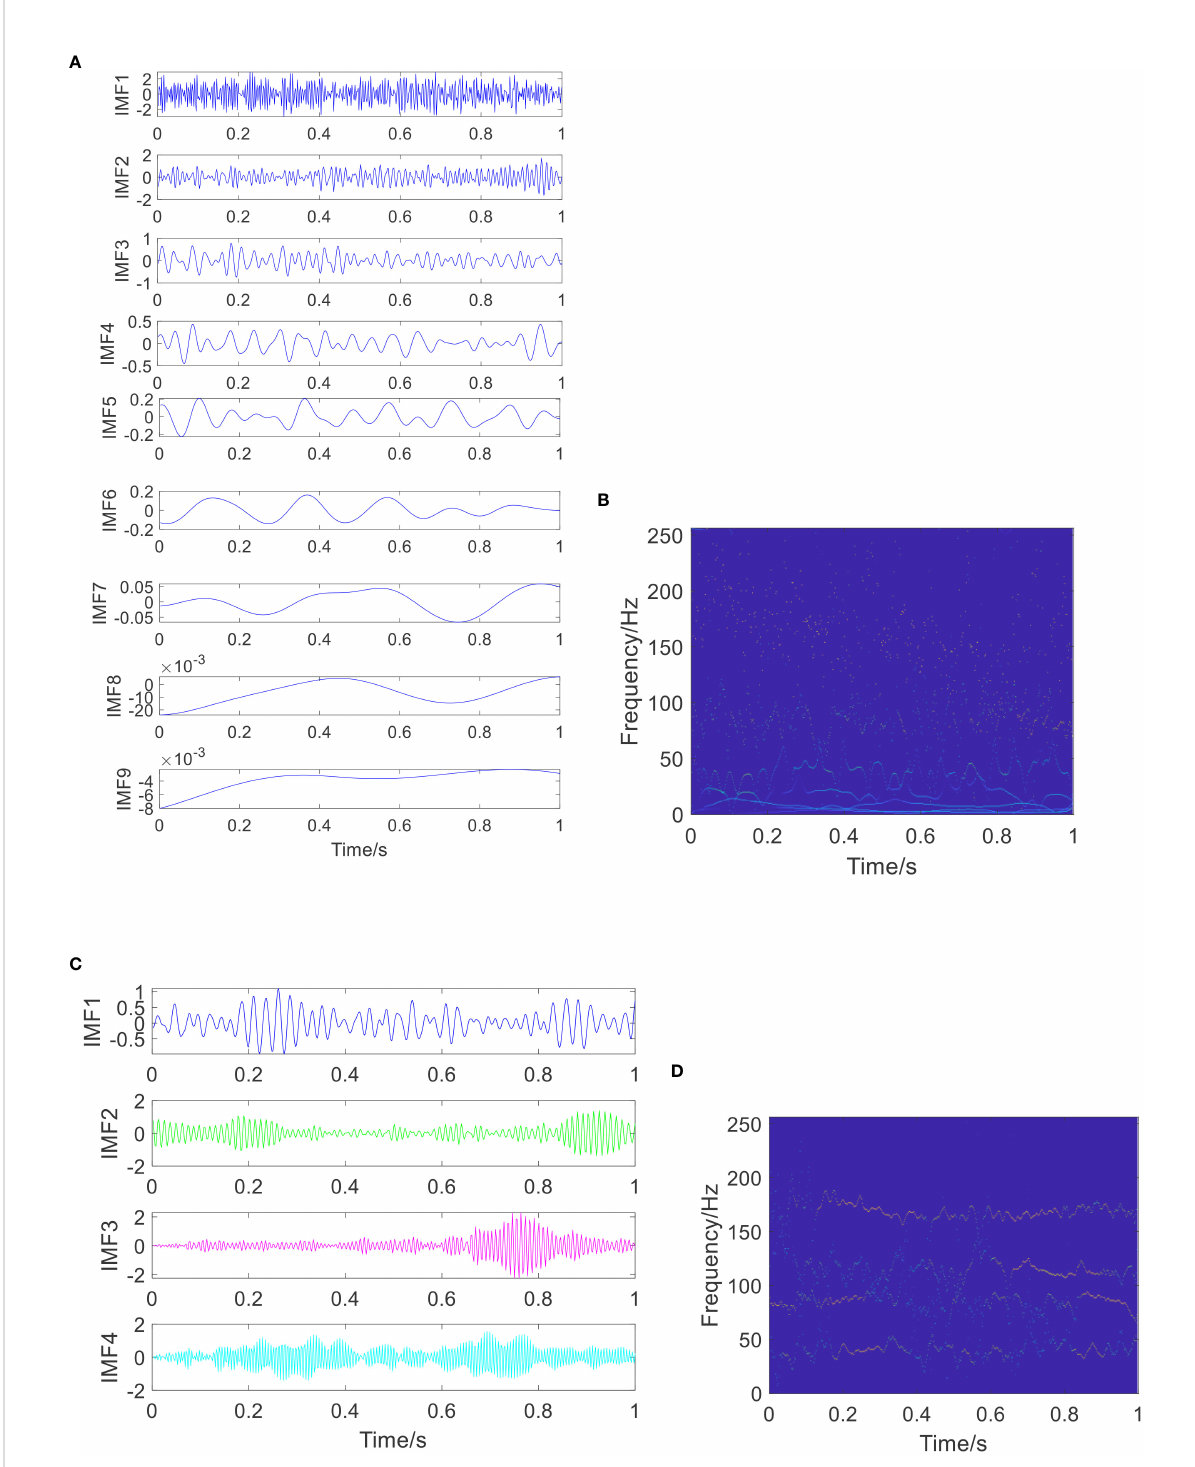
FIGURE 6 The estimated signal components and their estimated time-frequency plots using the EEMD and the VMD methods. (A) The estimated components using the EEMD method; (B) the estimated time – frequency plot of the estimated components using the EEMD method; (C) the estimated components using the VMD method; and (D) the estimated time-frequency plot of the estimated components using the VMD